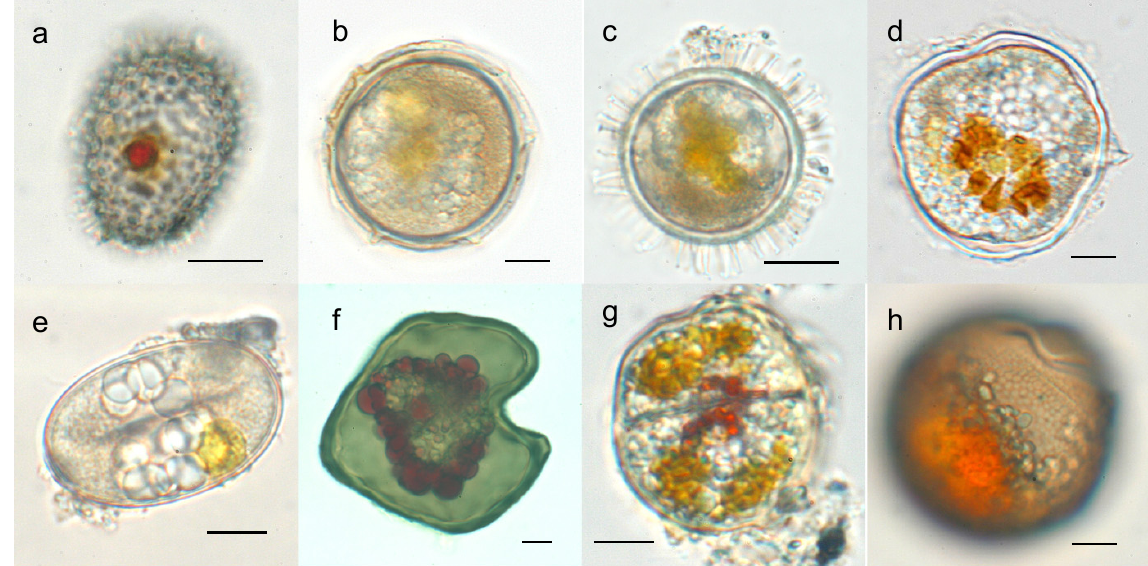
Figure 1. Resting cysts of Scripsiella sp. ( a ), Alexandrium pseudogoniaulax ( b ), Protoceratium reticulatum ( c ), A. taylori ( d ), A. tamarense ( e ), Protoperidinium oblongum ( f